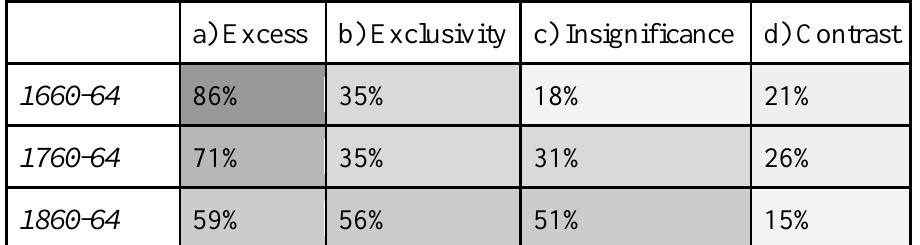
Table 3. Formal/morphological subtypes and associated